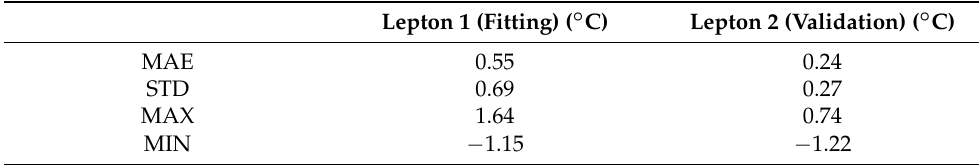
Table 4. Accuracy of the calibrated fitting and validation measurement.